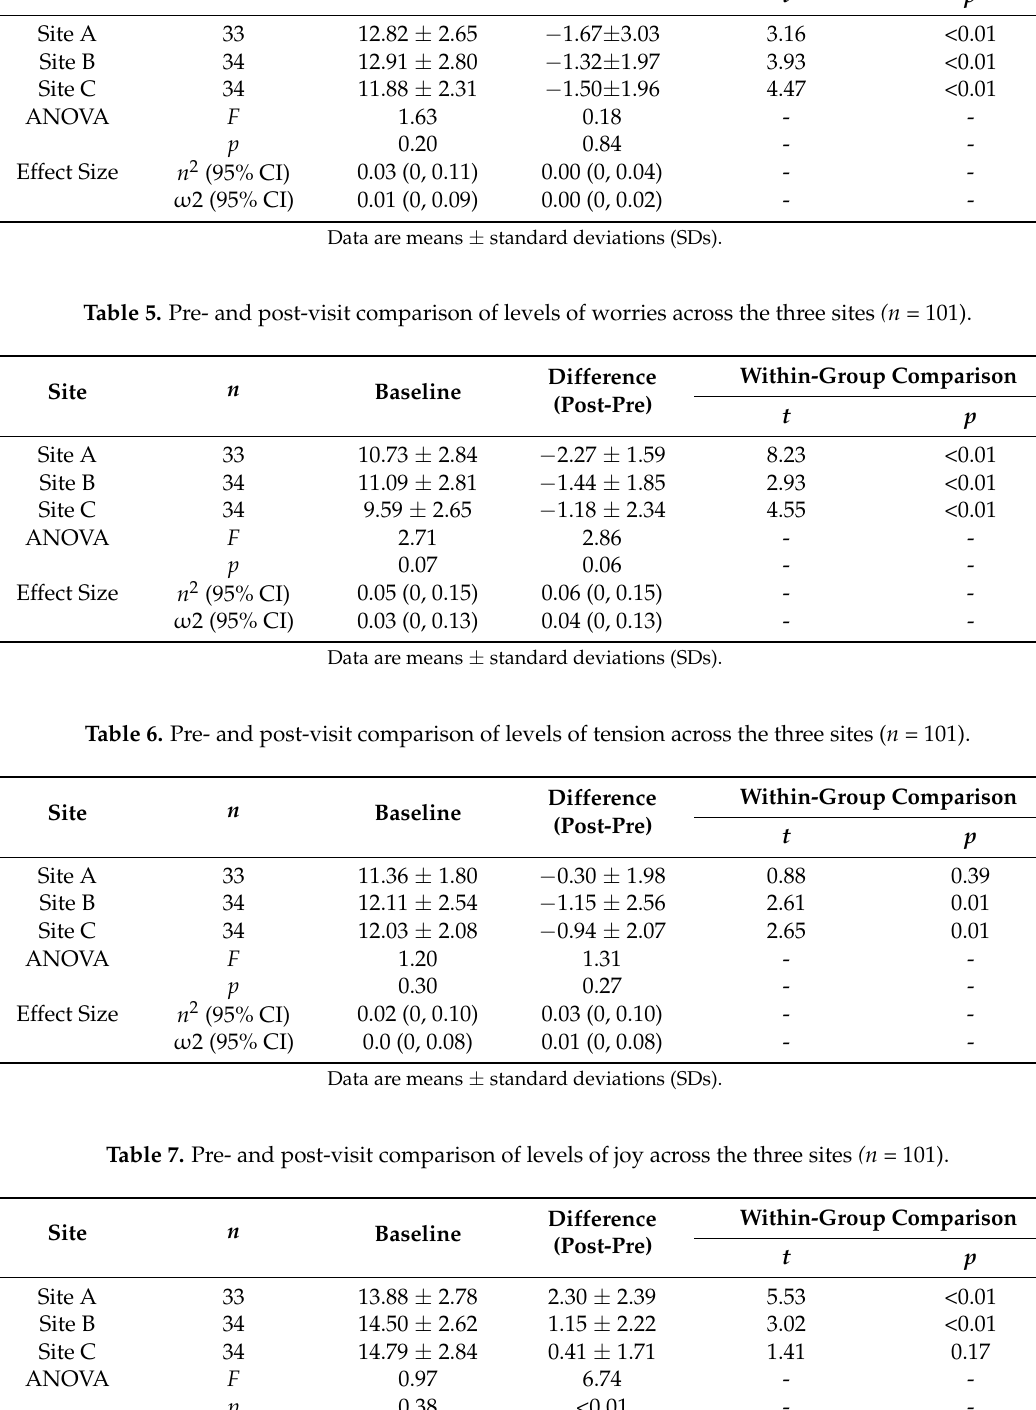
Data are means ± standard deviations